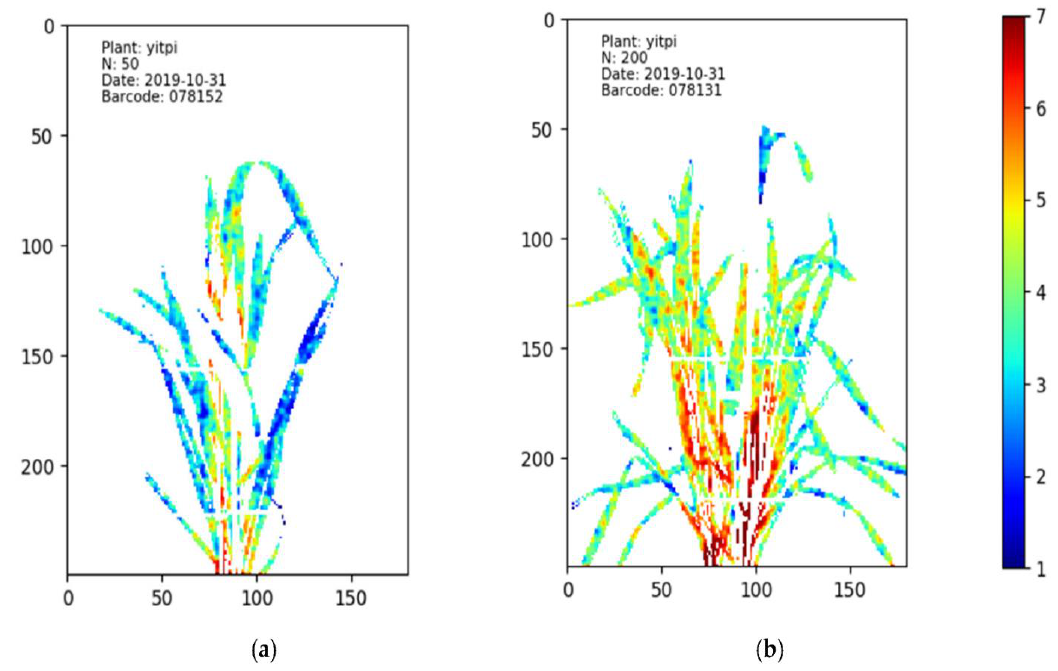
Figure 3. The HSI nitrogen (N) distribution maps of wheat cultivar Yitpi under different N treatments. Different levels of N% are presented using different colors, with red referring to the highest N% while blue refers to the lowest N% [78]. In image ( a ), the plant treated with 50 mg/kg N has more blue pixels than the plant treated with 200 mg/kg N, which is shown in image ( b ). This means that the leaves of the plant in image ( a ) contain lower N content than the leaves in the plant of image ( b ). The imaging date was 31 October 2019.